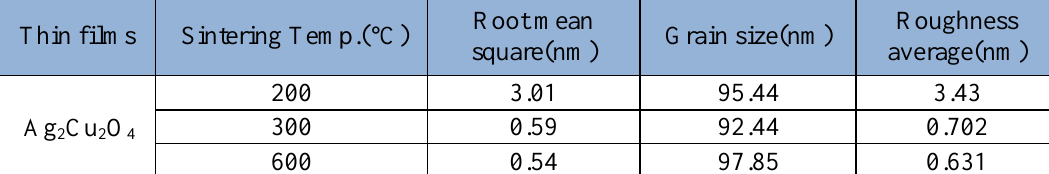
Fig.9: AFM image and histogram for Ag sintered at (a) 200 °C (b) 300 °C and (c) 600 °C. Table 8: Average grain size, average roughness , and root mean square for Ag-Cu-O films sintered at (200 °C, 300 °C and 600 °C) respectively. Thin films Sintering Temp.(°C)